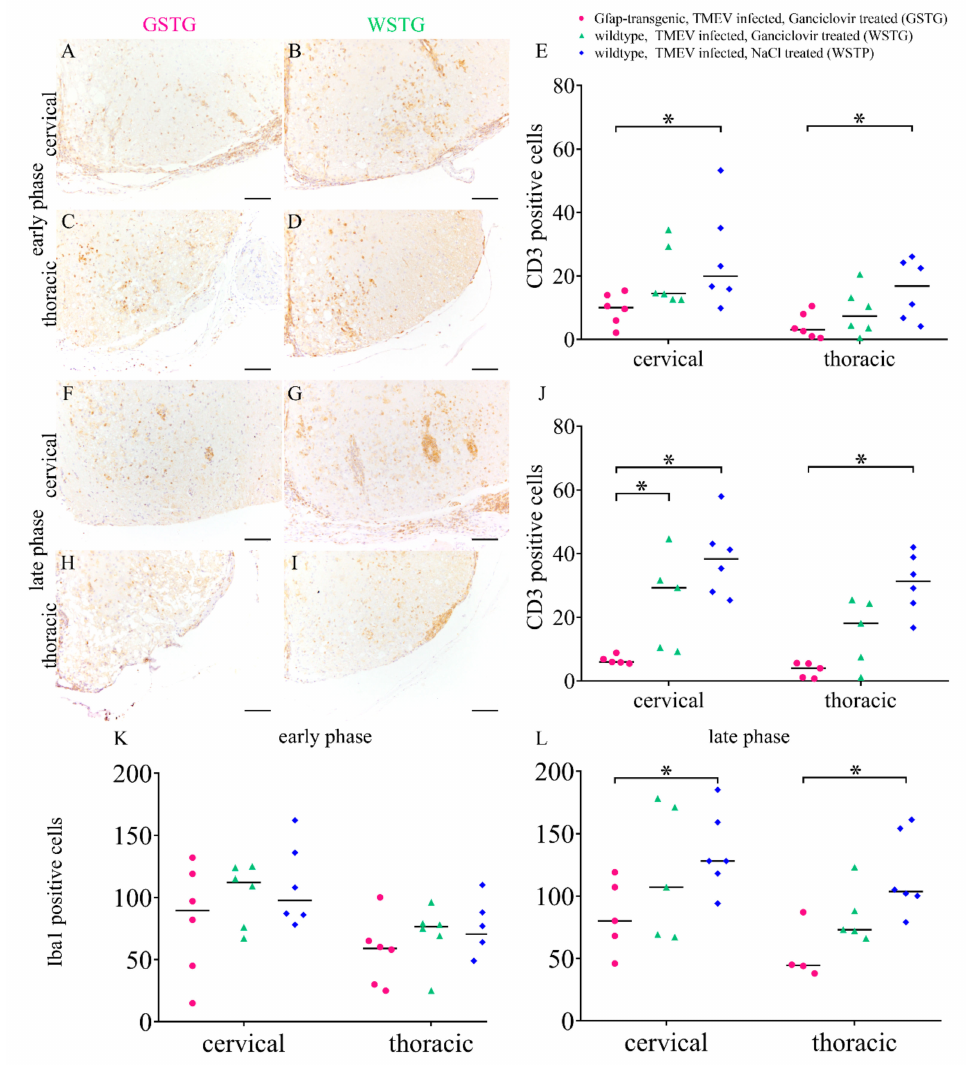
Figure 8. Immunophenotyping and quantification of inflammatory cells. T lymphocytes (CD3)